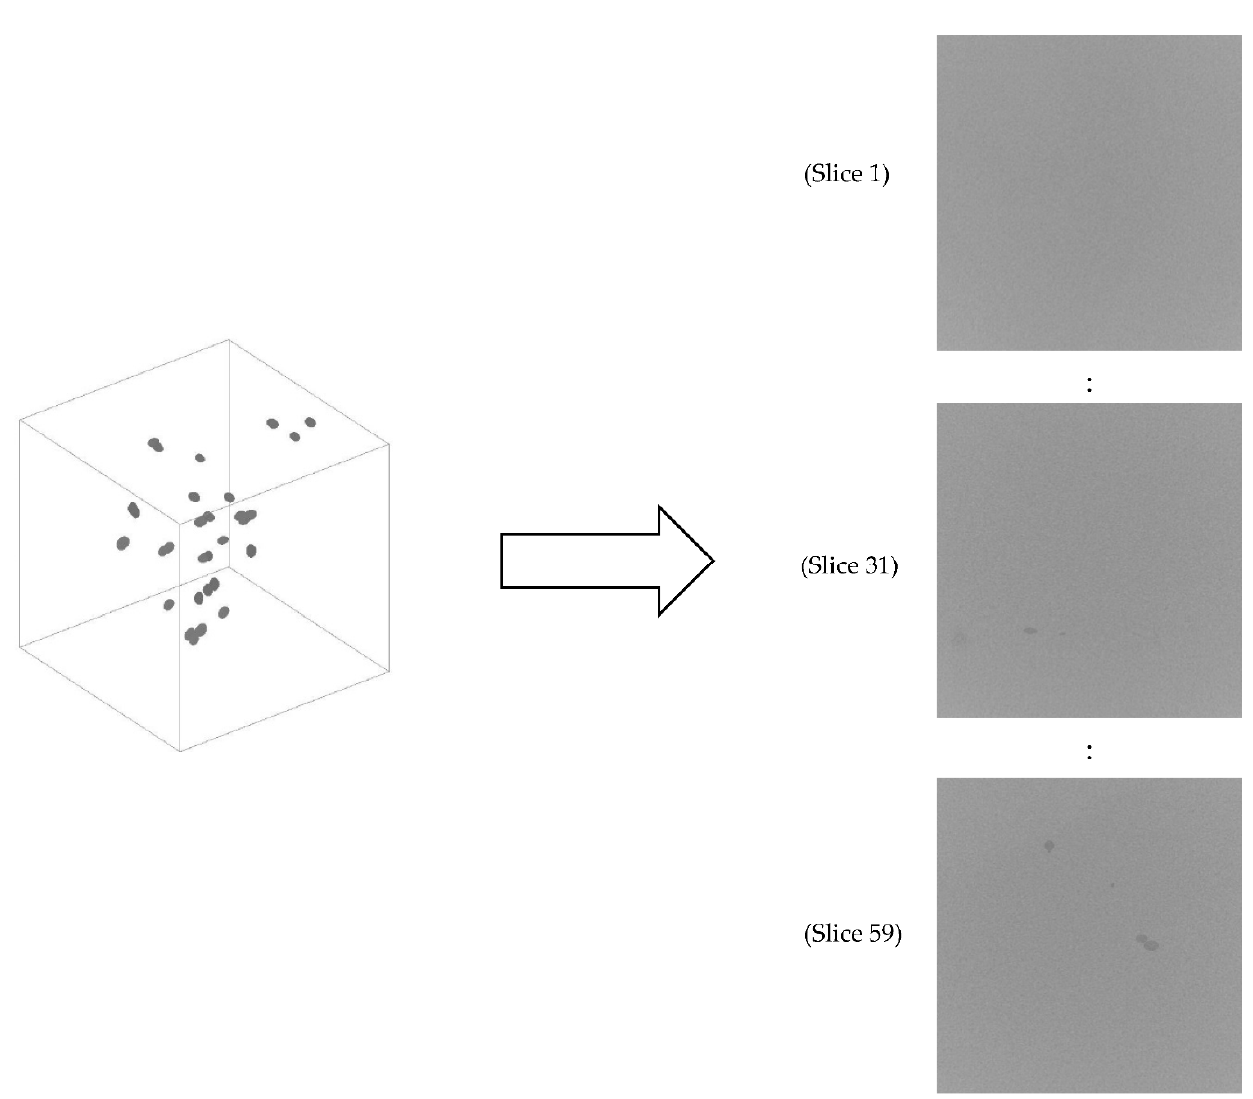
Figure 17. Illustrative example of the final version of artificial porosity